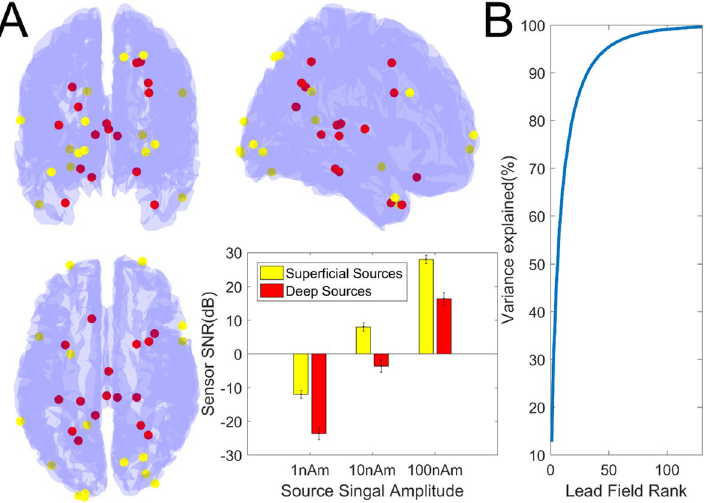
Figure 3. Source Locations, SNR and Lead Field Rank. In ( A ) the locations of the superficial sources are highlighted in yellow while the locations of the deep sources are highlighted in red. The resulting sensor level SNRs (in dB) obtained for our chosen signal amplitudes (1 nAm, 10 nAm and 100 nAm) are also shown (bar graph). Again, superficial and deep sources are signified in yellow and red respectively. In ( B ) we show the variance explained in our most densely sampled lead field (~ 700 sensors × 20,000 source locations) as a function of lead field rank (obtained by singular value decomposition of the lead field covariance matrix). The 95% and 99% variance explained points are approximately rank 50 and rank